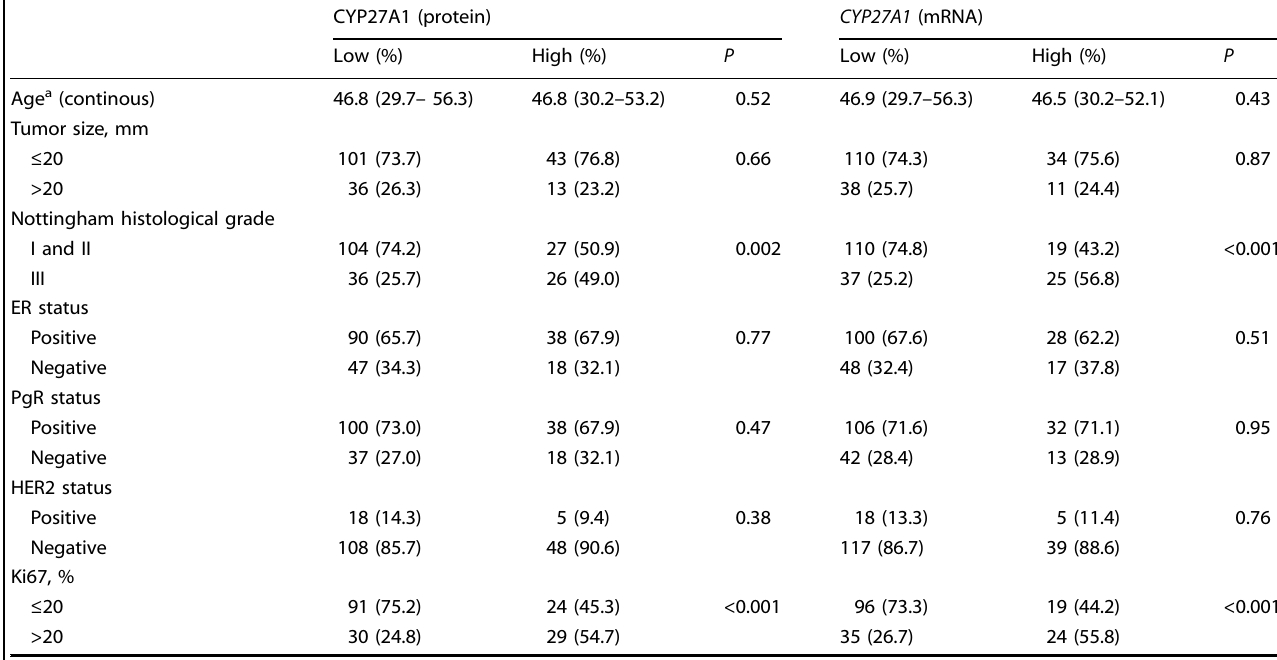
Table 1. Distribution of tumor pathological features according to CYP27A1 expression in 193 breast cancer